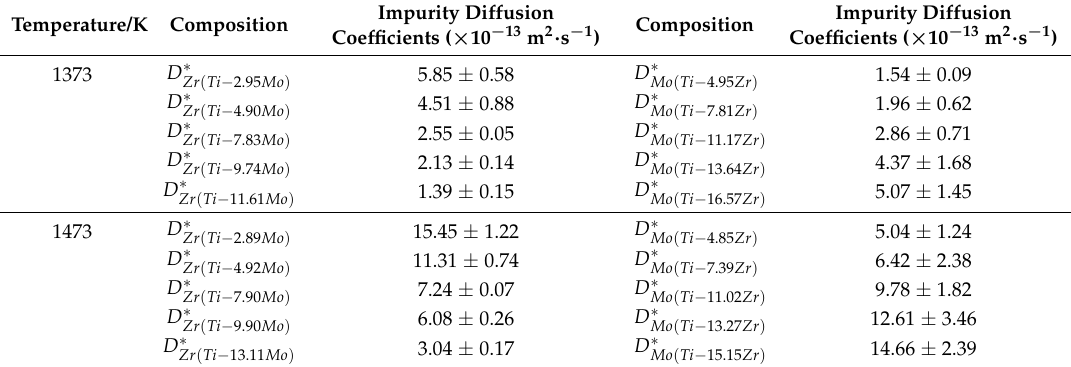
Table 3. Impurity diffusion coefficients of Zr in Ti-Mo and Mo in Ti-Zr alloys at 1373 K and 1473 K. Temperature/K